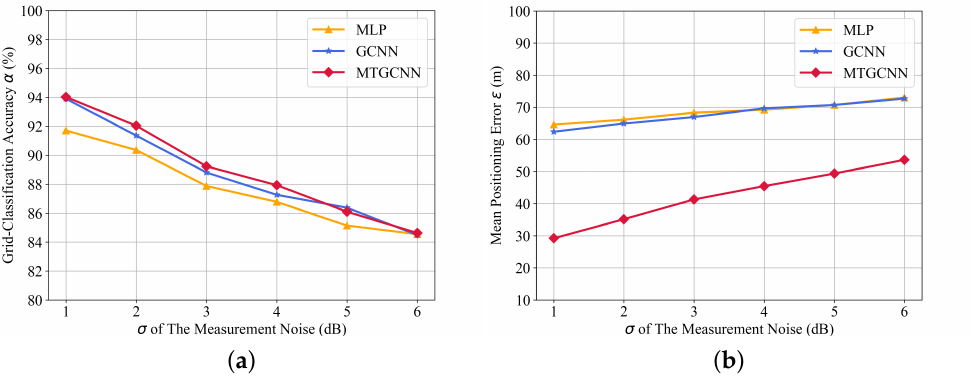
Figure 7. The localization results with different σ (dB) of noise. ( a ) grid-classification accuracy and ( b ) mean positioning